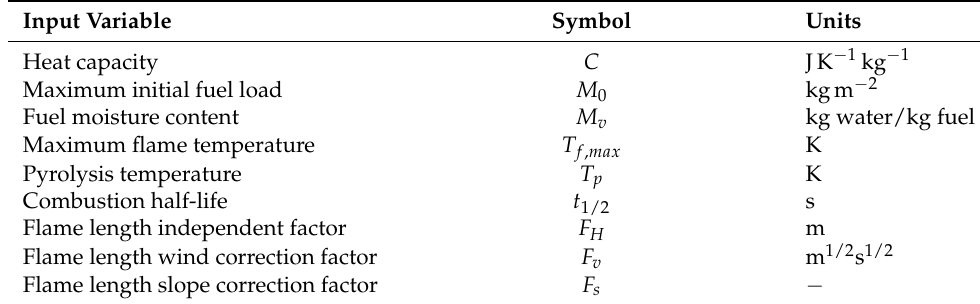
Table 2. Fuel-type-dependent input